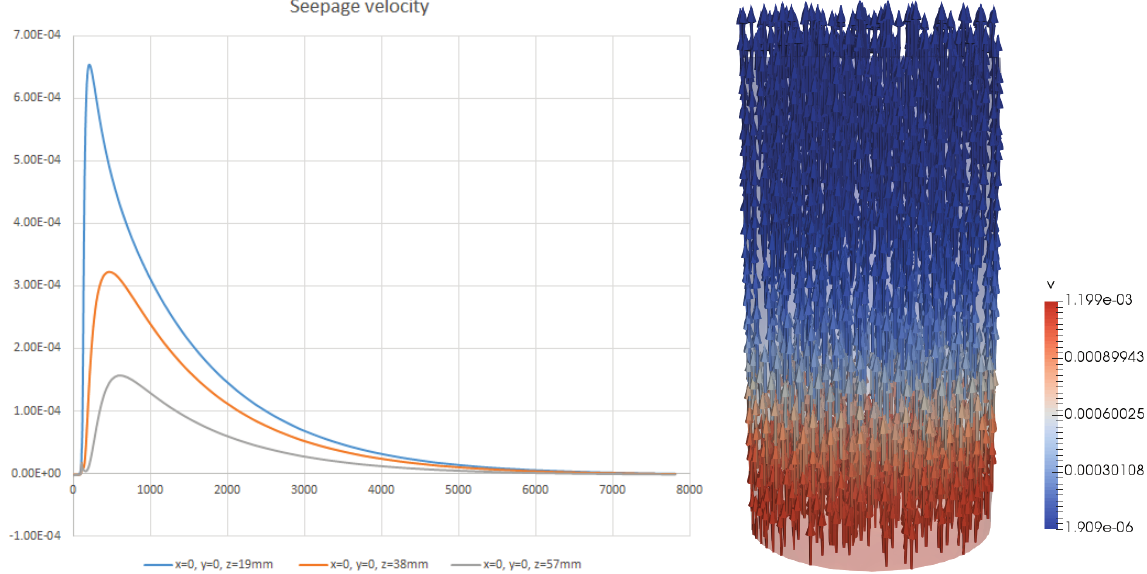
Fig. 5. Seepage velocity; to the left, at points: 0,0,19 mm; 0,0,38 mm; 0,0,57 mm; to the right, distribution of seepage velocity ( t = 180